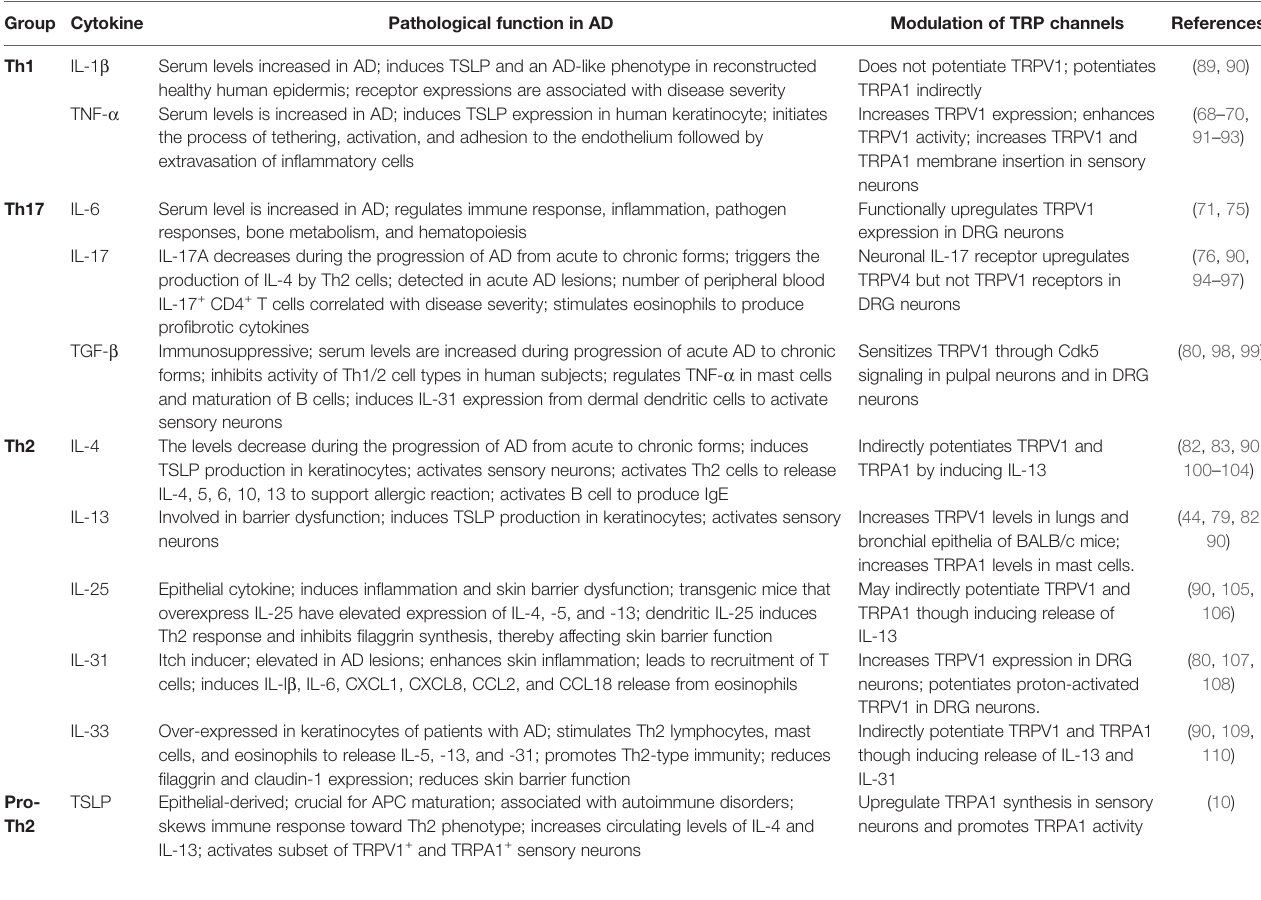
TABLE 1 | AD-related cytokines in modulation of TRP